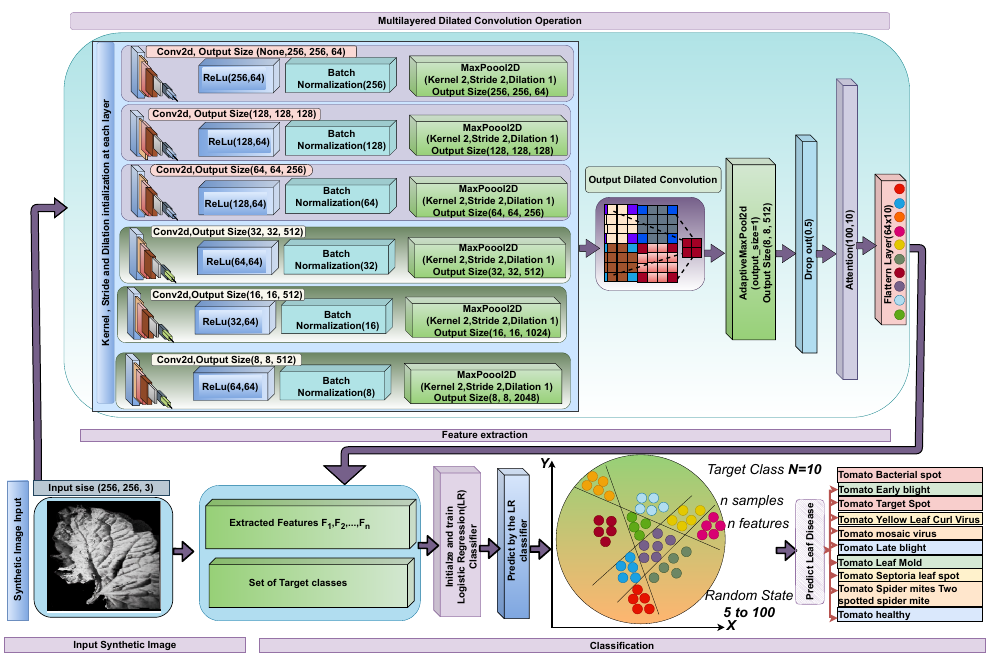
Figure 7. Overall operational process diagram of our ADCLR